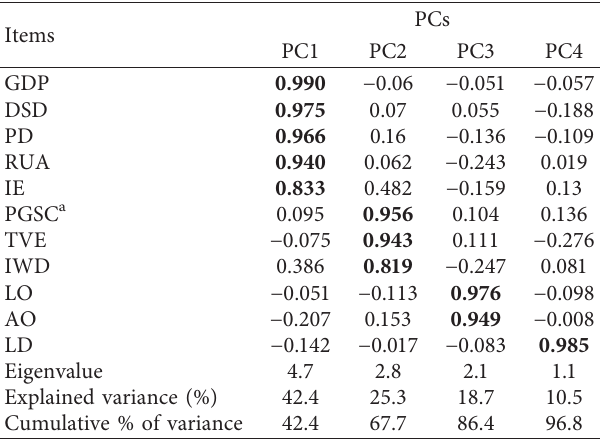
Table 4: Principal component (PC) loadings for proportions of groundwater salinity contamination and socioeconomic parame- ters in various cities in the Pearl River Delta